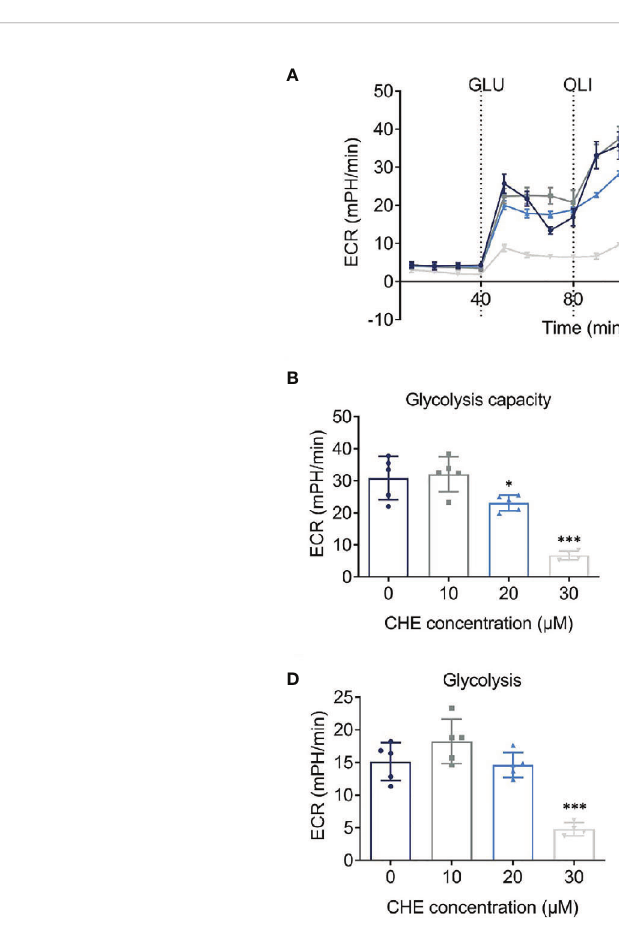
FIGURE 4 | CHE reduced the glycolysis capacity of HCC827 cells. (A) Extracellular acidi fi cation rate (ECAR) test of HCC827 cells after treatment with CHE; (B) Glycolysis capacity; (C) Glycolysis reserve; (D) Glycolysis; (E) Non-glycolytic acidi fi cation. (***p < 0.001, **p < 0.01, *p <